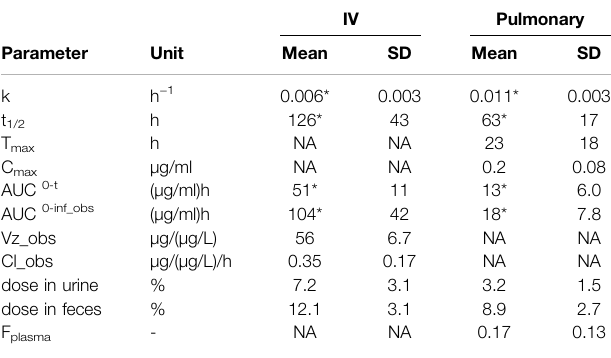
TABLE 1 | Plasma pharmacokinetic parameters of 3 H-liposomes after IV or pulmonaryadministration to sheep. Data are normalized to a dose of 1